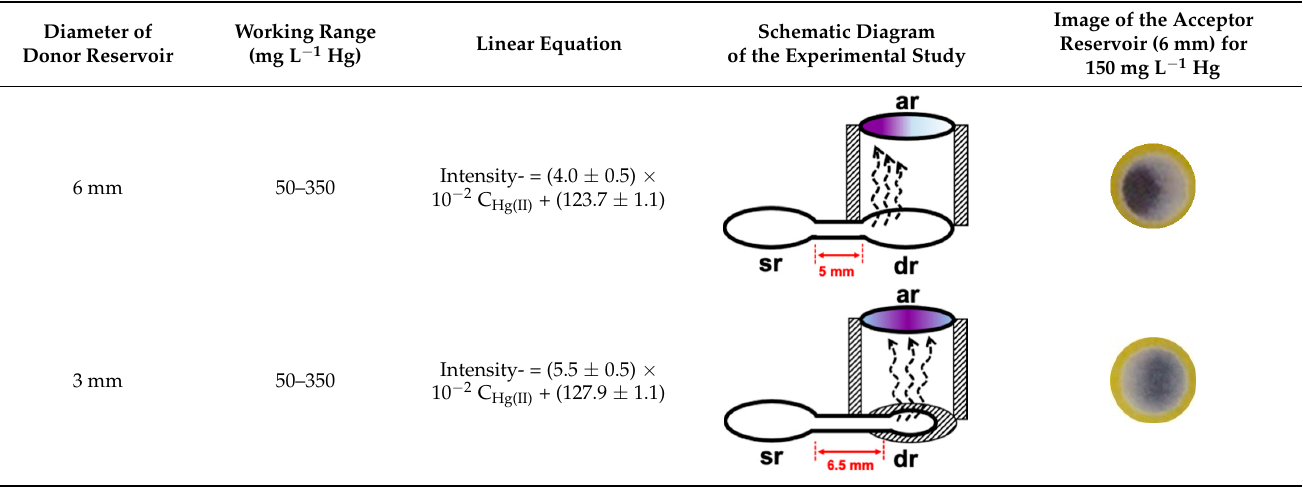
Figure 2. Illustration of the operating steps for the determination of mercury using the membraneless gas-separation µPAD .